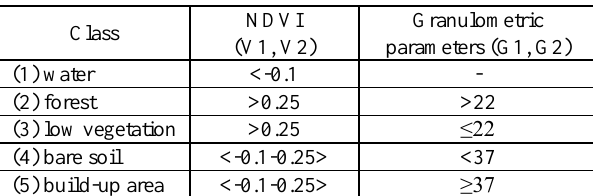
Table 2. Optimal values for V1, V2, G1, G2